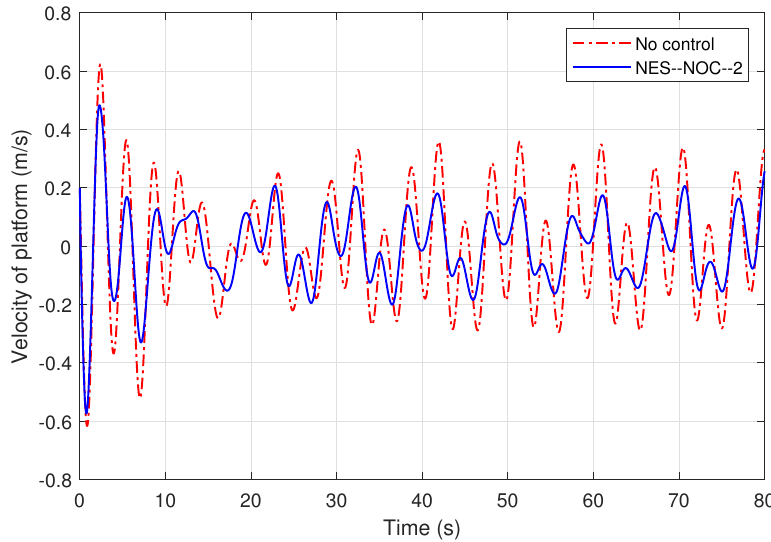
Figure 11. Velocities of the structure with NES–NOC–2.